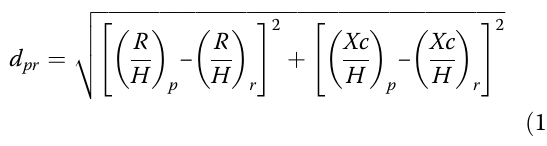
Table 2. For non-solid tumors, correlation coefficients (p-value) between (R/H) and (Xc/H) , θ and (R/H) , p p p p and θ and (Xc/H) were 0.42 ( p = 0.002), − 0.134 ( p = p p 0.513) and 0.298 ( p = 0.036), respectively. The samples used for these correlations are shown in Table 3. For both tumor types, similar correlation coefficients were reported when the analysis included R and Xc , θ and p p p R and θ and Xc . p p p